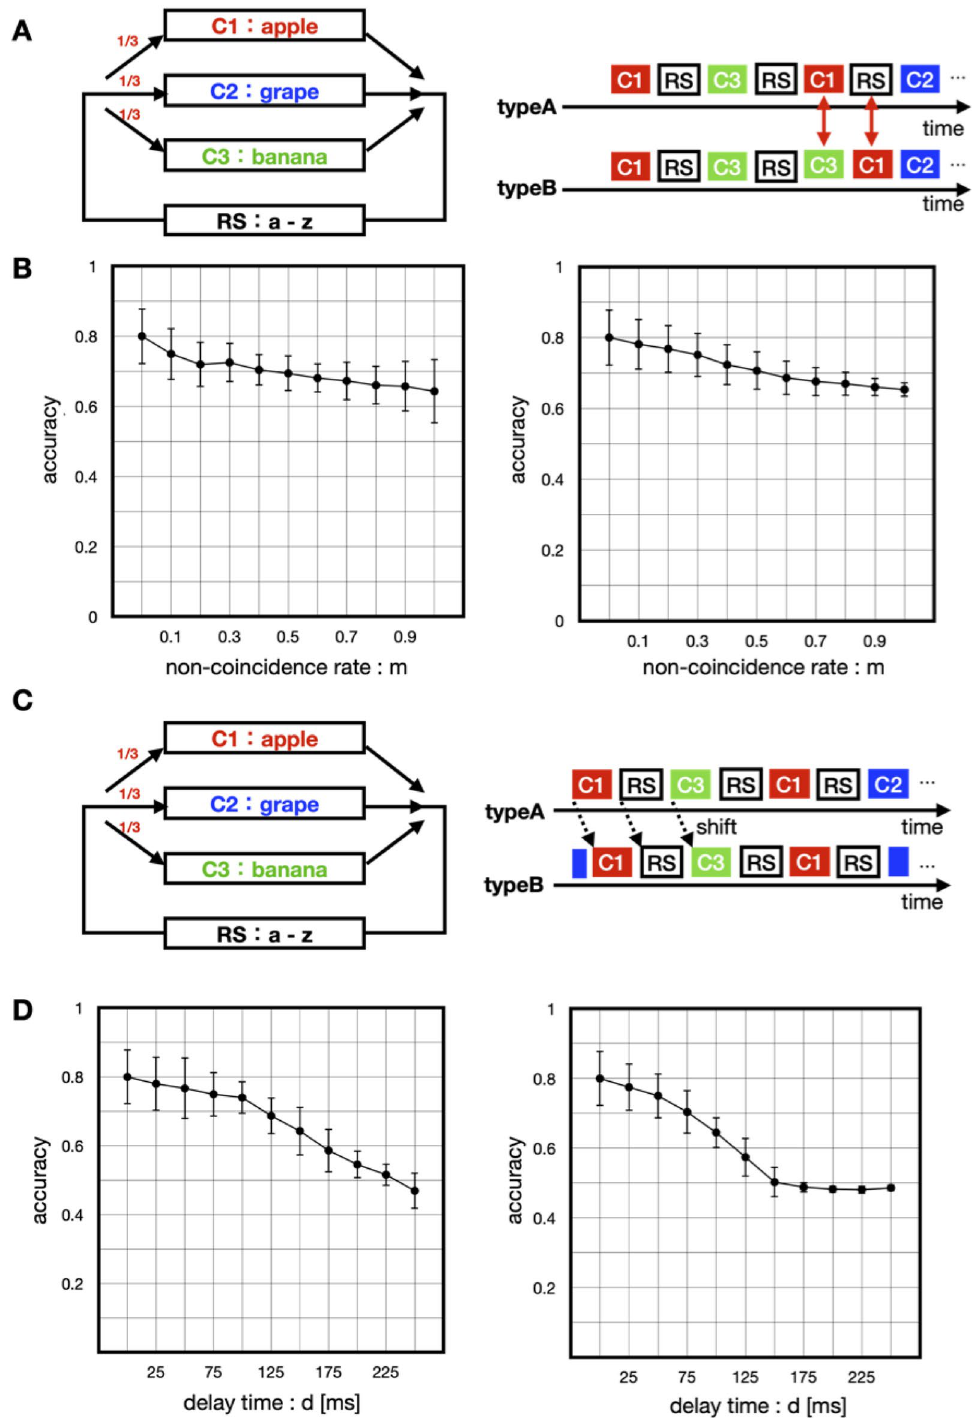
Figure 6. Reactions activated by non-contingent input through replacement and delay. ( A ) Three chunks of an apple (red), grape (blue), and banana (green) separated by random sequences recur at equal frequencies in the input. In non-co-occurrence signals, these chunks are swapped with a certain probability m . ( B ) Left: The relationship between non-coincidence m and the accuracy in training signals. Right: The relationship between non-coincidence m and the accuracy in testing signals. ( C ) Three chunks of an apple (red), grape (blue), and banana (green) separated by random sequences recur at equal frequencies in the input. In non-co-occurrence signals, these chunks are delayed with a certain time d . ( D ) Left: The relationship between the delay time d and the accuracy in training signals. Right: The relationship between the delay time d and the accuracy in testing